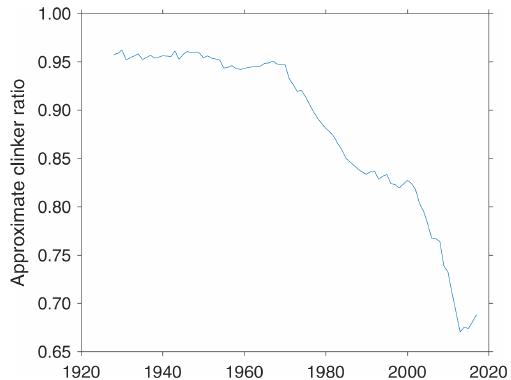
Figure A1. Approximate implied global clinker ratio, derived from emissions estimates and cement production data using default emis- sion factors. The trend up until 1990 is largely a result of the as- sumptions used in extrapolation, although in earlier years the data for the US and Europe